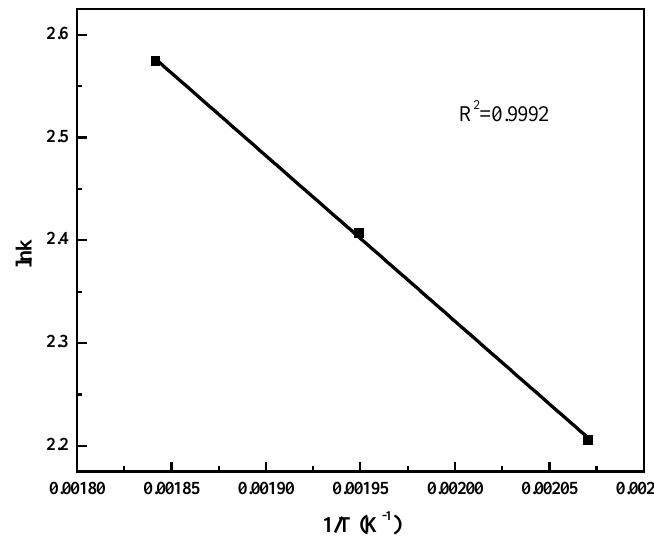
Figure 9. Arrhenius plot-based on LH model for FT synthesis over CoRu-SBA-15 catalyst.